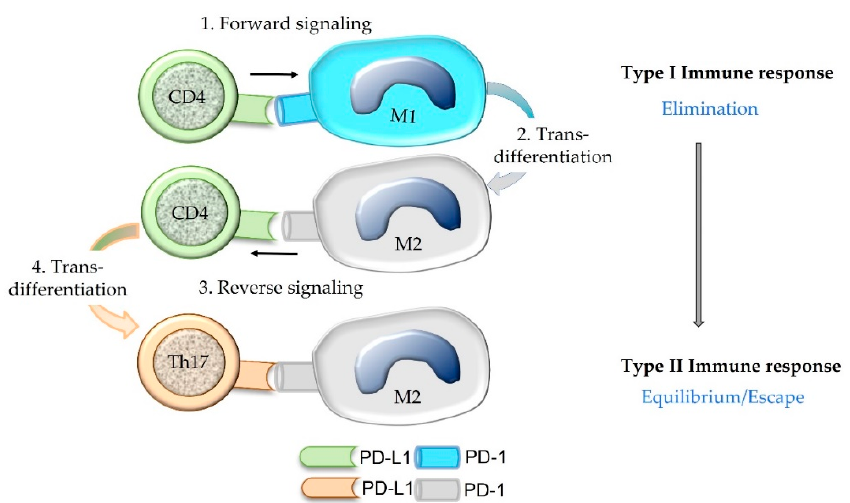
Figure 8. Binding of the ligand PD-L1 expressed on a CD4+ Th1 cell to its receptor PD-1 present on an M1 macrophage can induce M2 trans-differentiation of the PD-1-bearing target cell (forward sig- naling). Subsequently, the PD-1-bearing M2 macrophage may evoke trans-differentiation of the CD4+ Th1 cell into a Th17 cell by a process named reverse signaling. Within the tumor microenvironment, such a trans-differentiation of immune cells may contribute to the shifting of an anti-cancer type I immune response to a type II immune response that is associated with an equilibrium between cancer and immune cells or cancer immune escape.